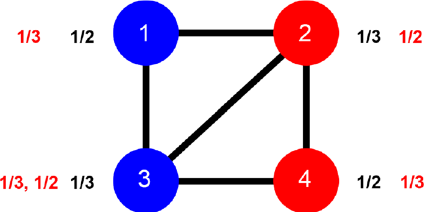
Figure 1. Defining first-order and second-order homophily in a network. Here, the first-order homophily of each node is their proportion of friends of the same type, shown in black. The second-order red homophily of each node is either the list or the mean of the first-order homophily values of the node’s red neighbors. The list version of second-order red homophily of each node is shown in